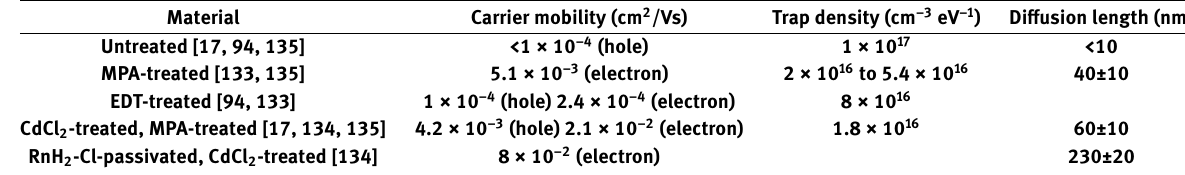
Table 1. Summary of electronic properties measured in PbS CQD solar cell films employing different ligand strategies.